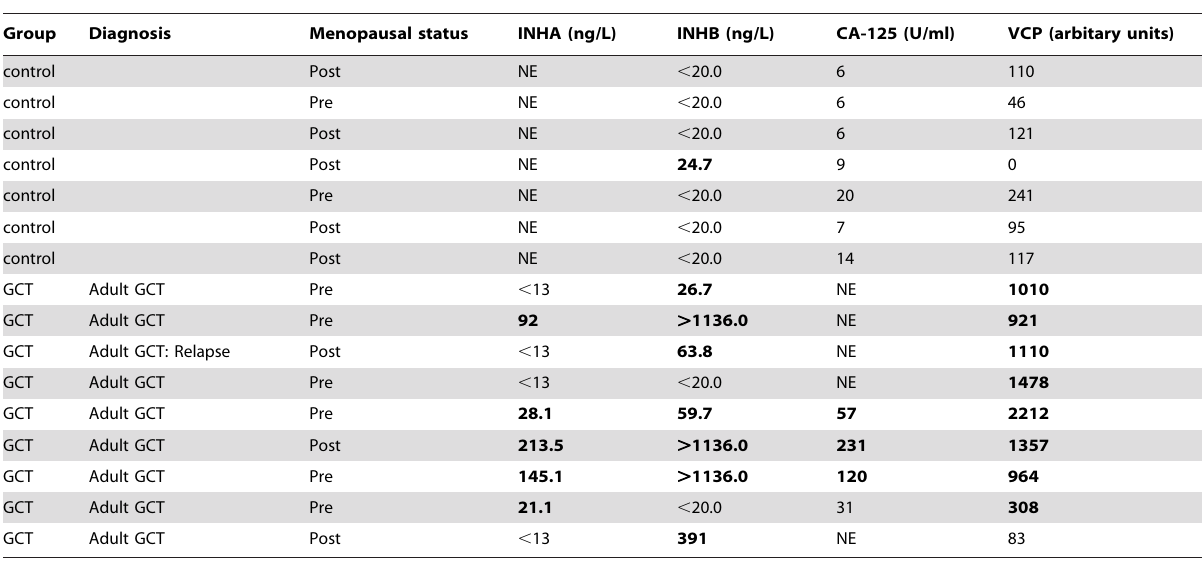
Table 2. Serum levels of GCT markers in healthy women or in women with GCT.